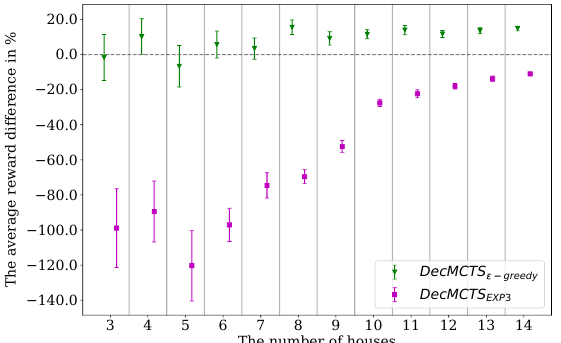
Figure 11. The average cumulative reward difference in % over different number for houses of fire fighting problem. 0.0 line represents the performance of UCT . The whiskers show the standard